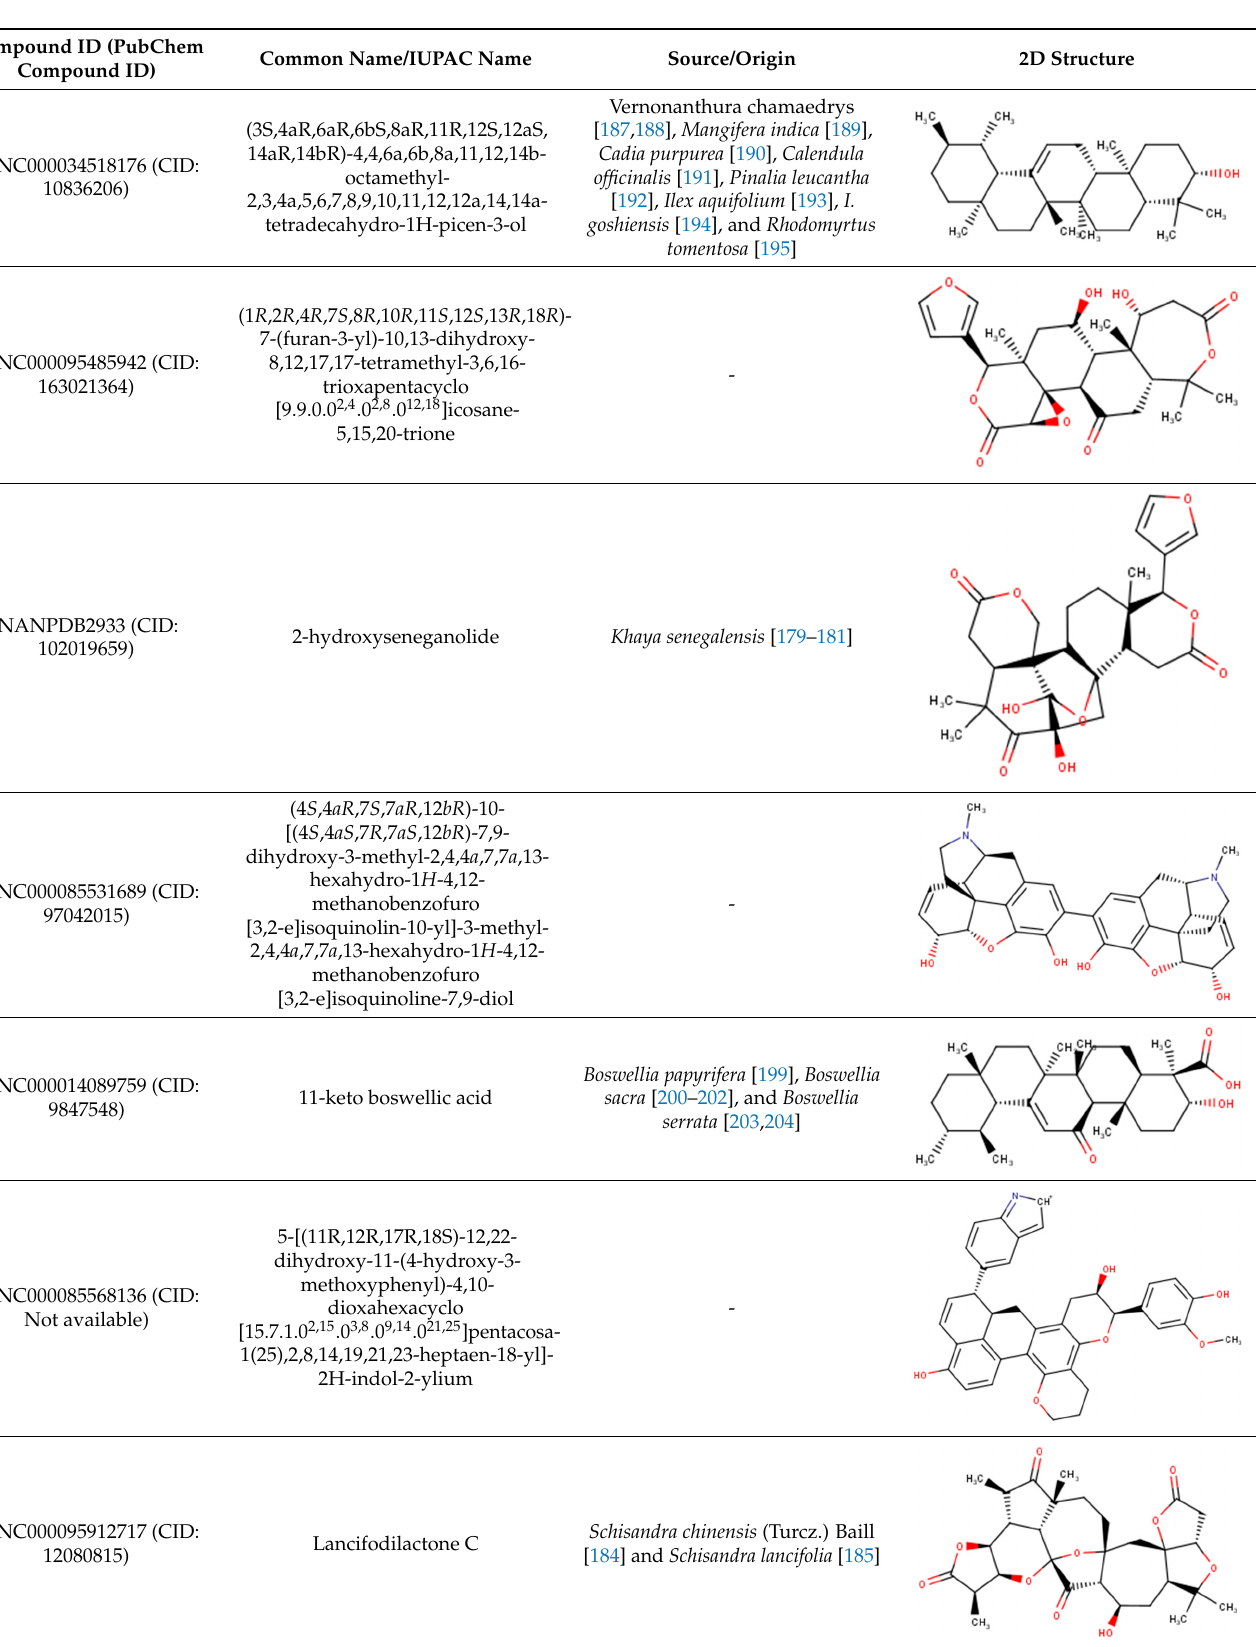
Table 4. Names, PubChem IDs, 2D structures, and sources of the potential lead compounds. Marvin 23.3.0 by ChemAxon (https://www.chemaxon.com accessed 11th March, 2023) was used to generate the 2D structures.